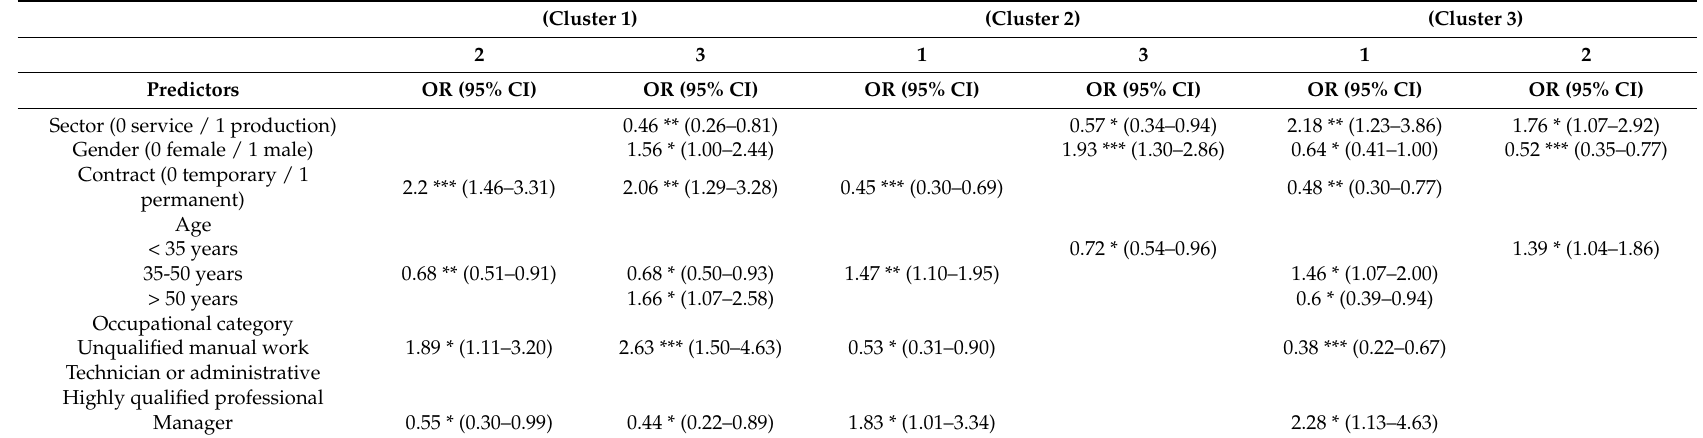
Table 6. Multinomial logistic regression analysis of factors associated with the clusters. Model 4: Eudaimonic (E) Performance supervisor